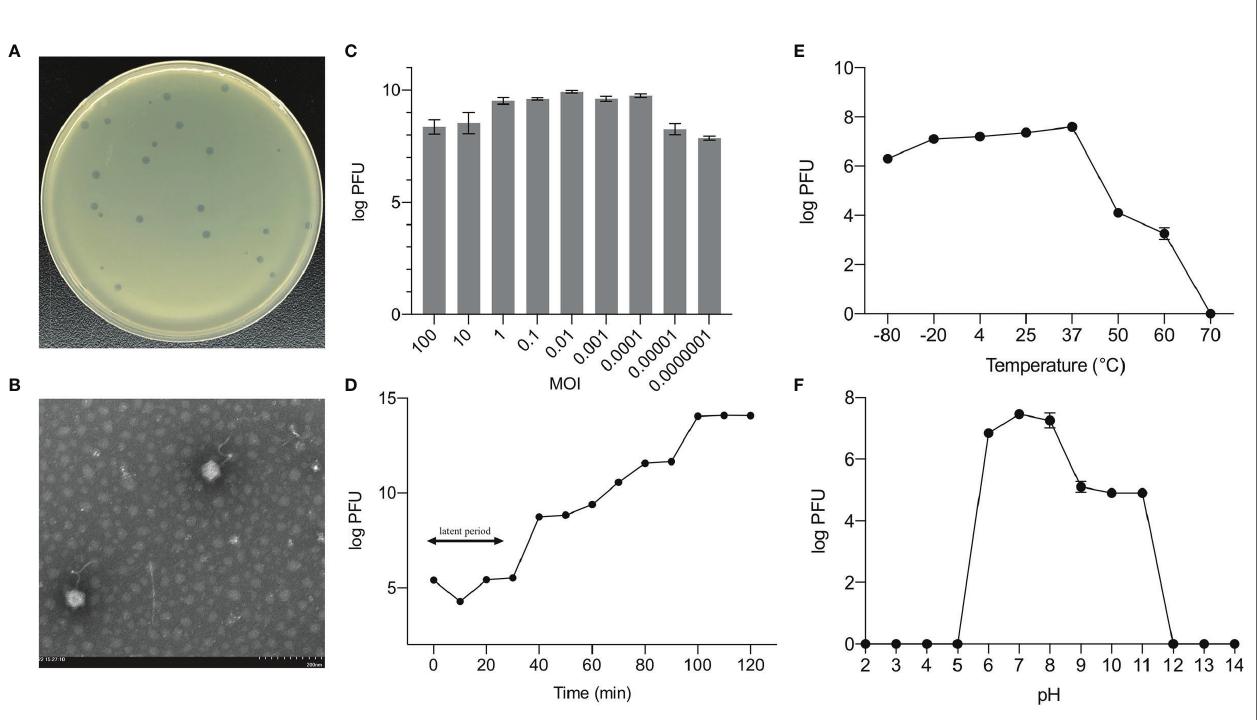
FIGURE 1 | Biological properties of E. hormaechei phage Phc. (A) Morphology of bacteriophage plaques in nutrient agar medium. The plaques of Phc are medium in size and transparent. (B) Electron micrograph of negatively stained, puri fi ed bacteriophages used in this study. The Phc was a Caudovirales with uncontracted tails. (C) The MOI of phage Phc. E. hormaechei strain was infected with phage phc at various MOI (0.000001 – 100) and incubated at 37 C for 5 h. (D) One-step growth curve of phage Phc. Phage Phc has a short latent period and large burst size against E. hormaechei . (E) The thermal stability of phage Phc. Phage Phc (~10 8 PFU/mL) was incubated at various temperatures ranging from -80 to 70°C for 1 h. (F) The pH stability of phage Phc. Phage Phc is stable over a relatively narrow range of pH values, and it ( ∼ 10 8 PFU/mL) was incubated at different pH values ranging from 5 to 12 at 37°C for 1 h. Values are means ± standard deviations from triplicates of each